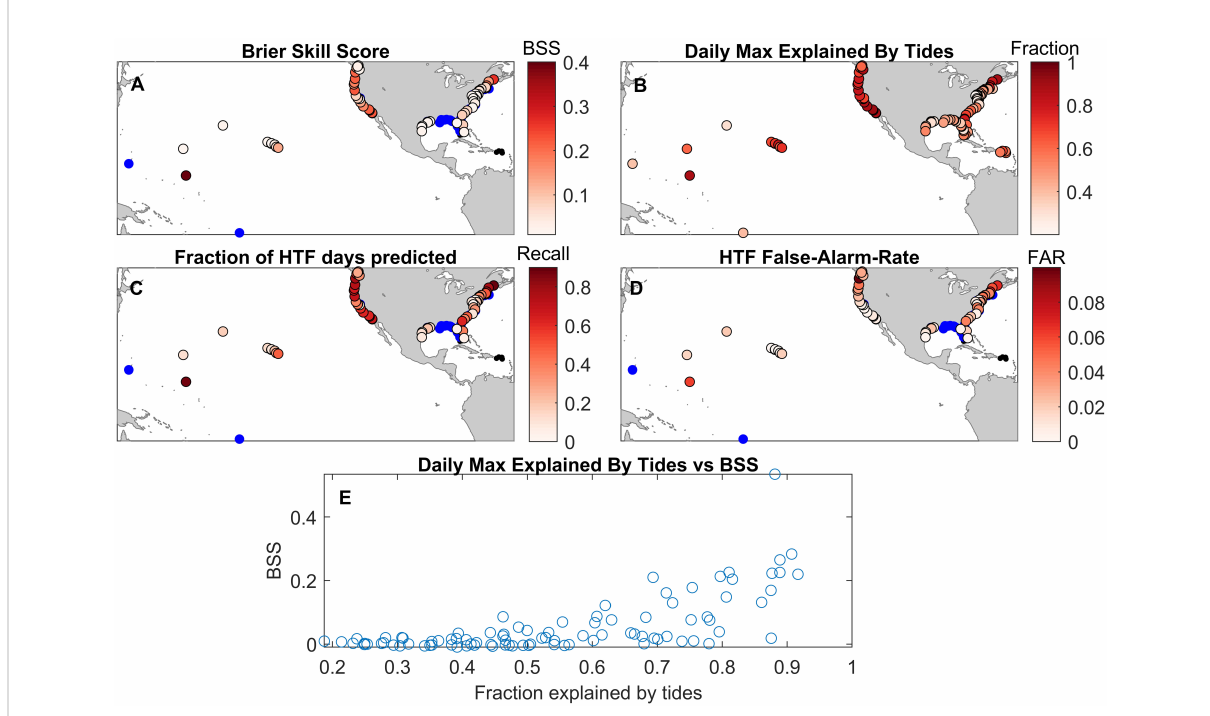
FIGURE 4 The Brier Skill Score (BSS) for each tide gauge (A) . The fraction of the daily maximum observed water level variance explained by tides (B) . The fraction of HTF days predicted when using a 5% warning threshold (C) and the false-alarm-rate when using that same 5% threshold (D) . A scatter showing the relationship between BSS and the fraction of the daily max water level explained by tides is shown (E) . In the maps, blue dots indicate insigni fi cant skill (BSS< BSS Conf.), while small black dots (Caribbean and Florida Keys) indicate less than 10 HTF days occurred over the 1997 – 2019